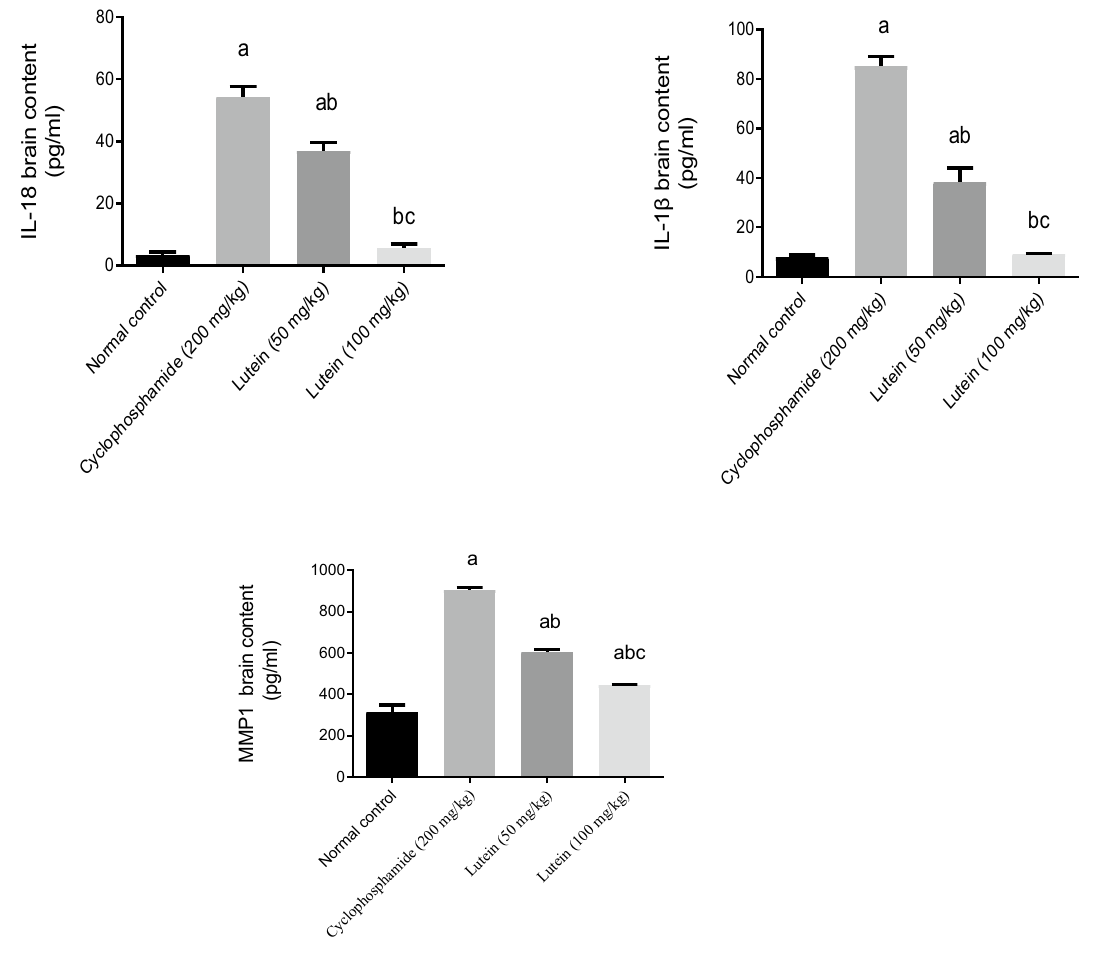
Figure 4. Effects of lutein on IL-18, IL 1β, and MMP1 brain contents. a Significant compared to the control group. b Significant compared to the Cyclophosphamide group. c Significant compared to Lutein 50 group at P < 0.05.